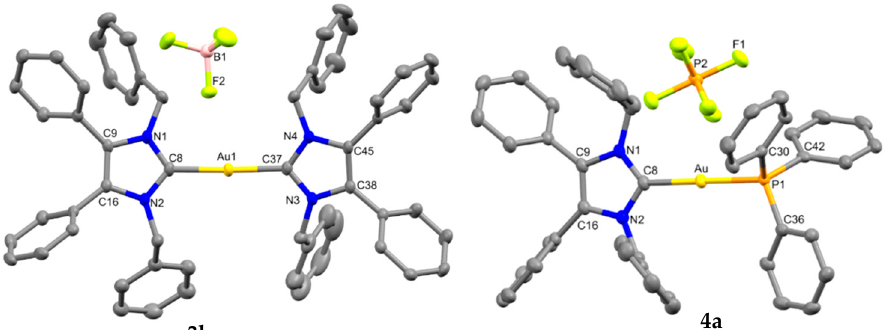
Figure 4. X ‐ ray diffraction structures of [NHC* 2 Au]BF 4 ( 3b ) and [NHC* ‐ Au ‐ PPh 3 ]PF 6 ( 4a ); thermal ellipsoids drawn on the 50% probability level. Hydrogen atoms have been omitted for clarity. Table 1. Selected bond lengths (Å) and angles (°) of complexes 2b – 5e .